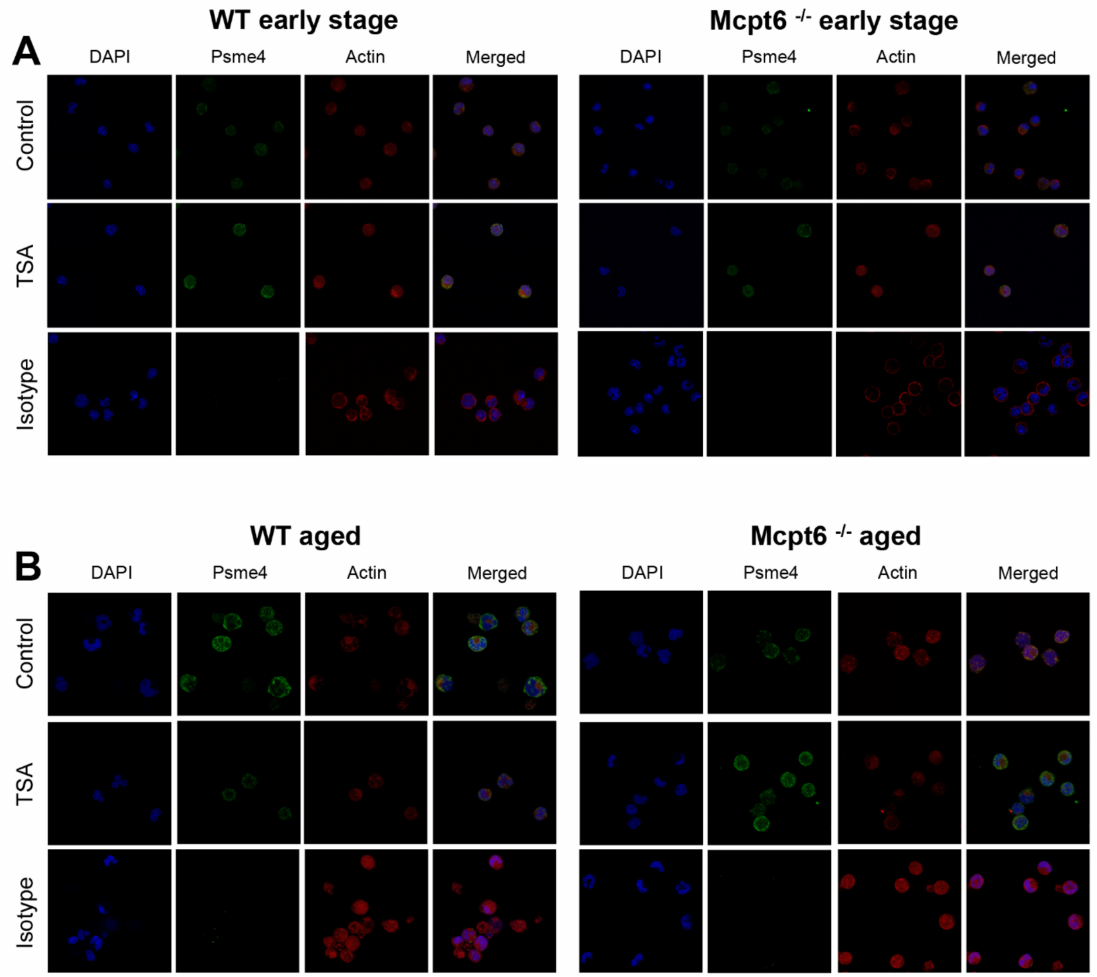
Figure 7. TSA causes upregulated expression of Psme4 / PA200 in aged Mcpt6 − / − MCs but downregulated expression in aged WT MCs. Confocal microscopy analysis of early stage ( A ) and aged ( B ) WT and Mcpt6 − / − MCs that were either cultured alone (Control) or with TSA as indicated, followed by staining with DAPI (blue), Psme4 / PA200 (green) and actin (red). The lower panels represent staining with the isotype control for the Psme4 / PA200